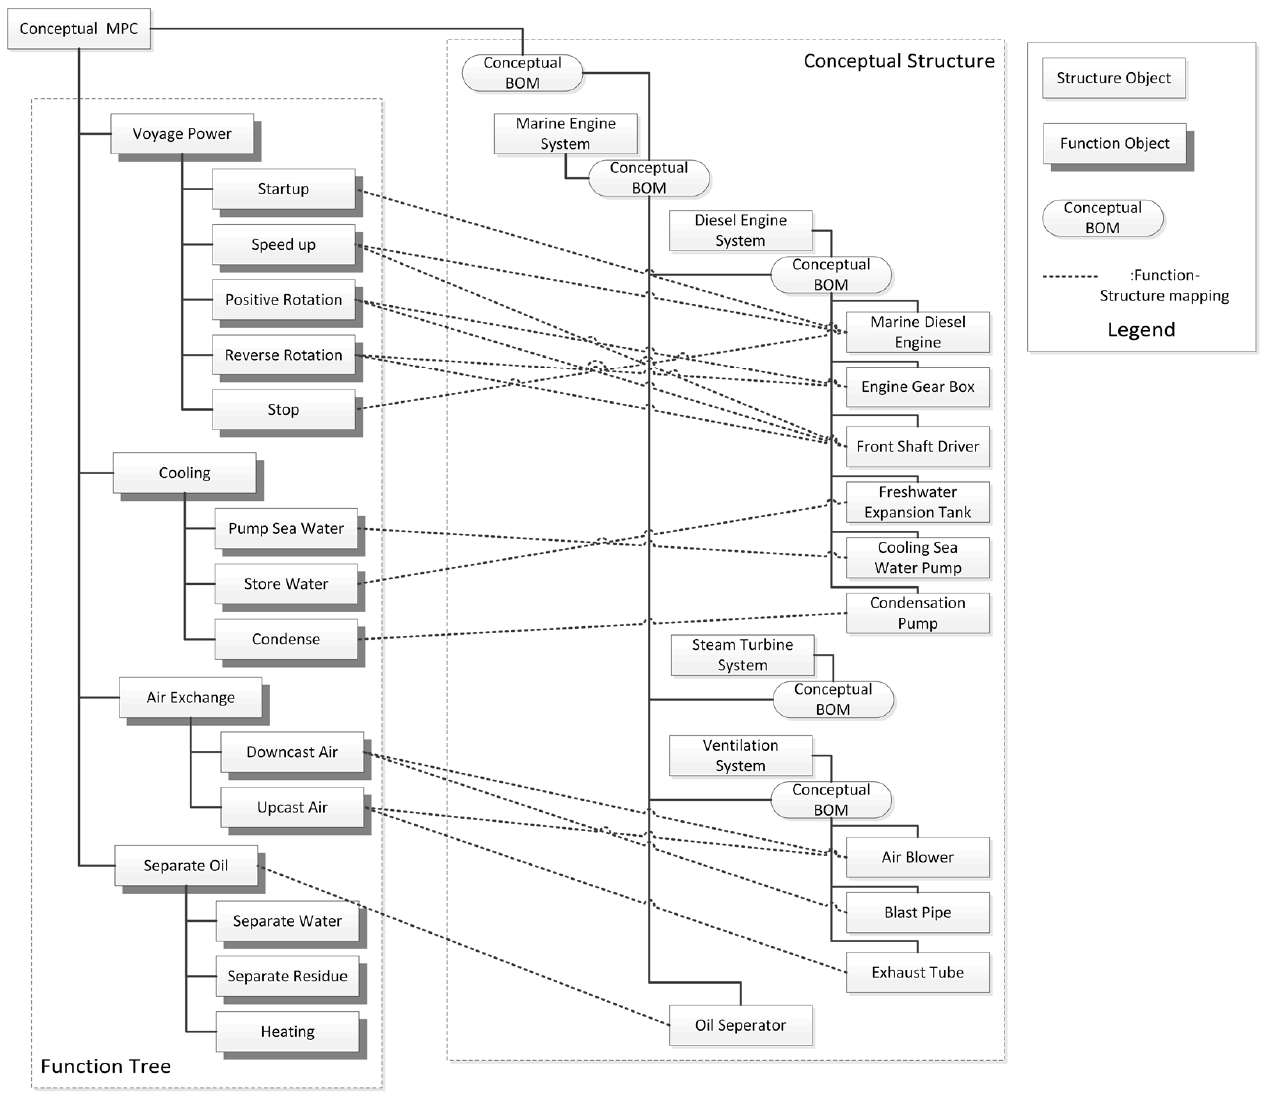
Figure 12. Conceptual Ship—Multi Purpose Container vessel.